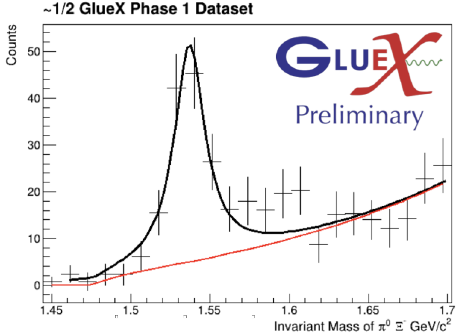
Figure 9. Preliminary invariant mass spectrum of the π 0 Ξ − subsystem in the reaction γ p → K + K + Ξ ∗− → K + K + π 0 Ξ − → K + K + γγπ − Λ → K + K + γγπ − π − p . The Ξ ∗− (1530) can be clearly identified as a peak at the expected mass.